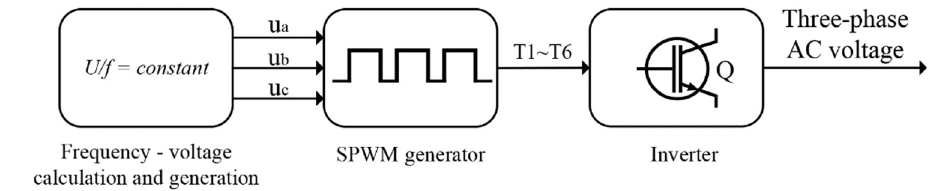
Figure 5. Inverter driving schematic.